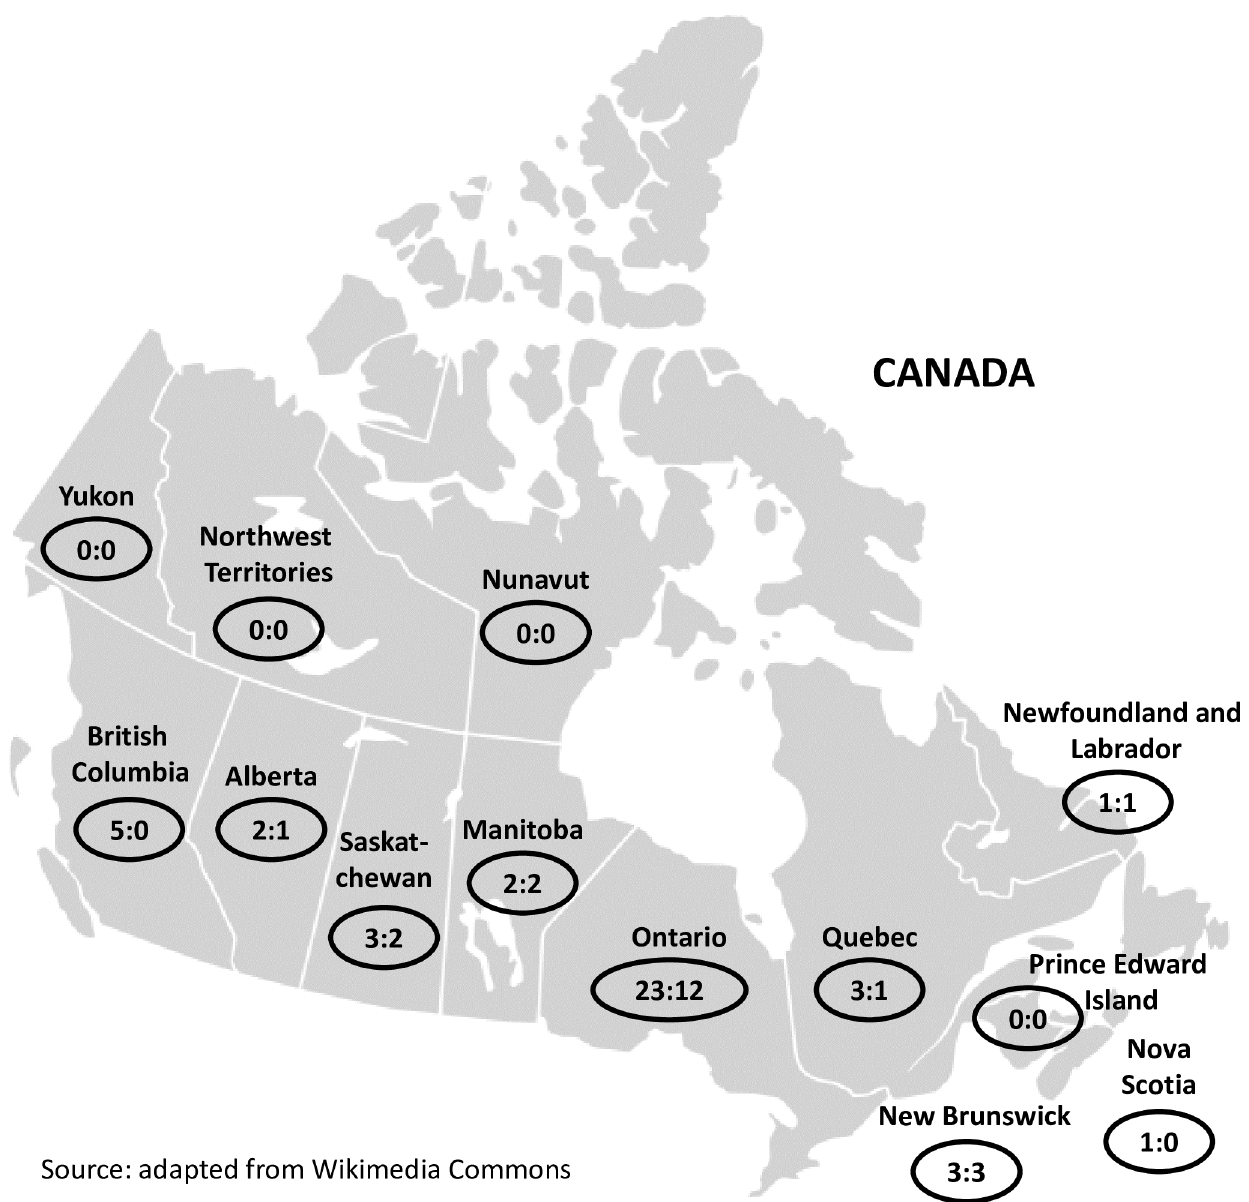
Fig 1. Location and number of invited and participating HIV care settings (# invited: # completed). https://doi.org/10.1371/journal.pone.0199395.g001 Table 1. Patient population and proportion of patients living with HIV at participating HIV care settings. All settings Primary care setting Specialist care setting (n = 22) (n = 12) (n = 10) All patients Patients with HIV All patients Patients with HIV All patients Patients with HIV Total 38,060 17,678 29,910 12,060 8,150 5,618 804 (885) 2,493 (3234) 815 (1209)